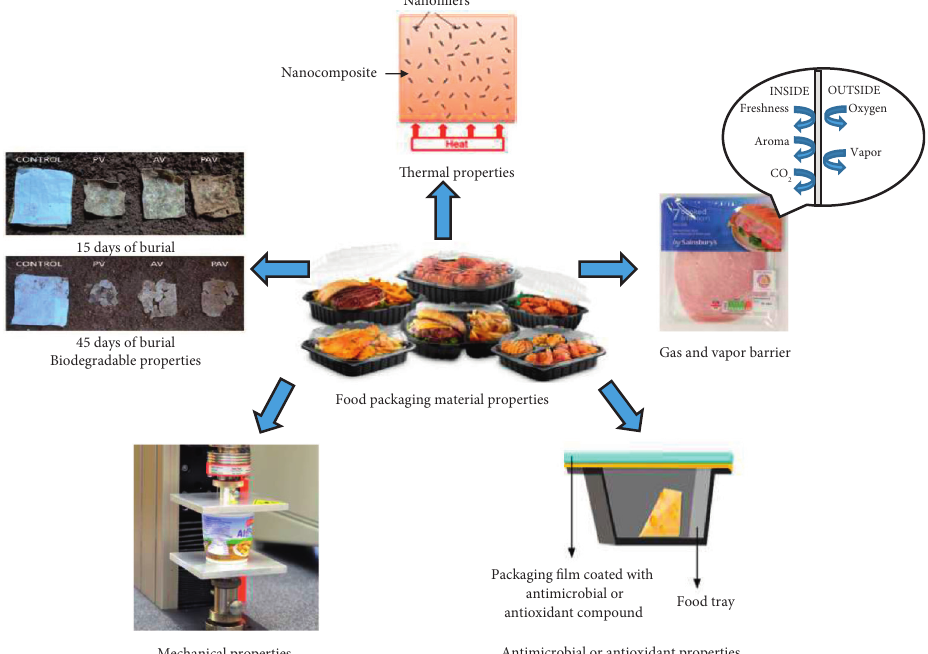
Figure 3: Properties of food packaging materials